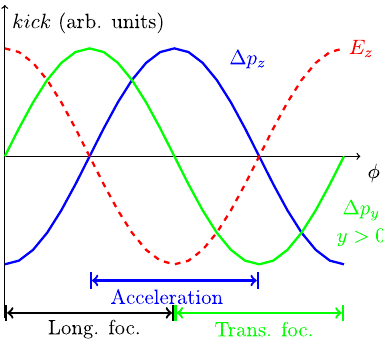
FIG. 9. Overview of electron acceleration and focusing proper- ties for an x-invariant grating.